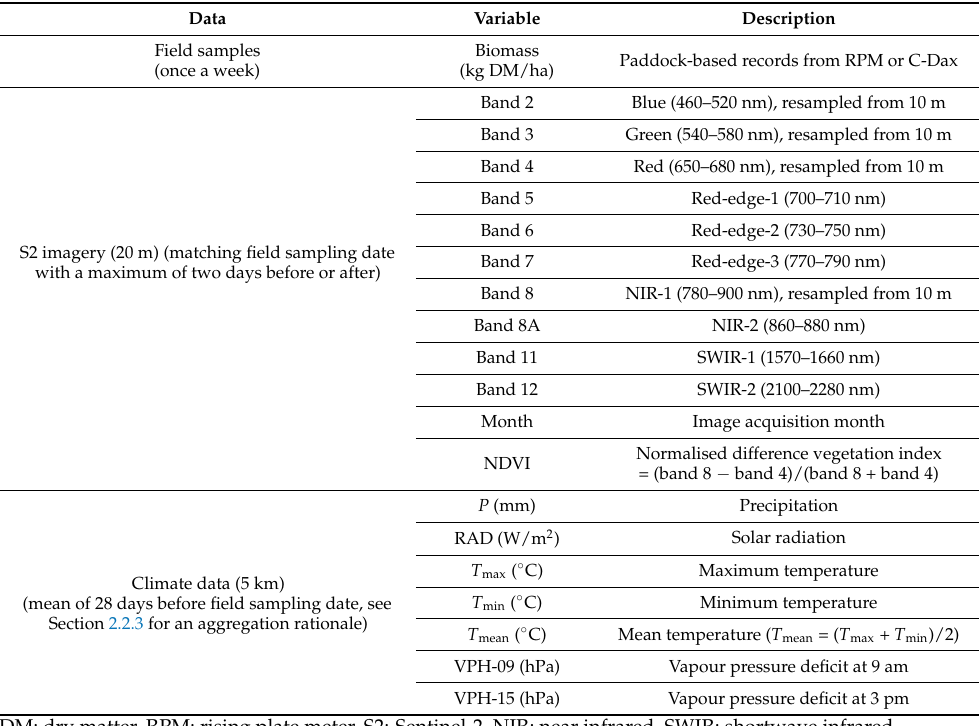
Table 1. Summary of the input data/variables from five farms in the study area (2017–2018).